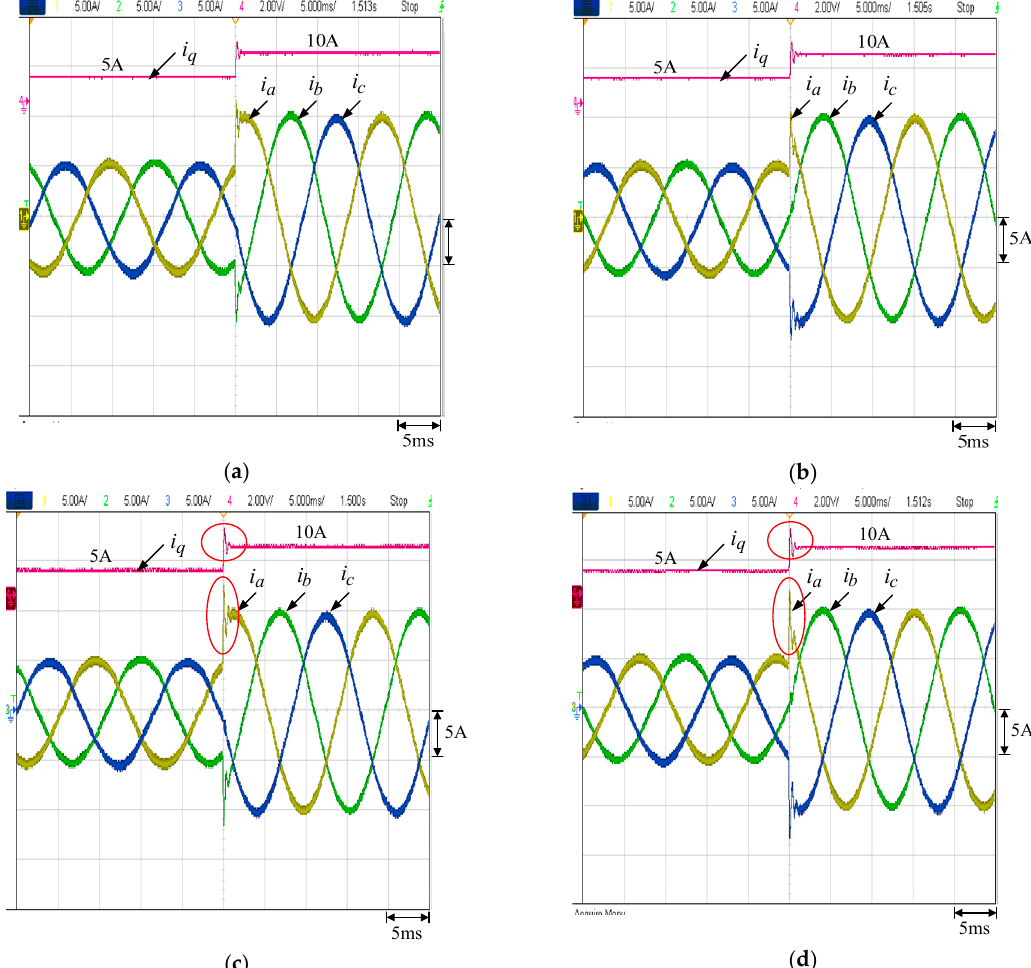
( b ) Figure 8. Winding current waveforms of the current command is varying as 0 A → 5 A → 10 A → 15 A → 10 A → 5 A: ( a ) 900 rpm; ( b ) 1500 rpm. 5.3. Calculation Time The calculation time of the IT2 T-S fuzzy and the IT1 T-S fuzzy systems is compared in Figures 9a,b. The calculation time of the IT2 T-S fuzzy is 32.6 µs and the calculation time of the IT1 T-S fuzzy is 30 µs. The IT2 T-S fuzzy system requires 2.6 µs more than the IT1 T-S fuzzy system to process the control algorithm. The switching period of the developed system is 50 µs. Therefore, the proposed algorithm is acceptable in implementation.